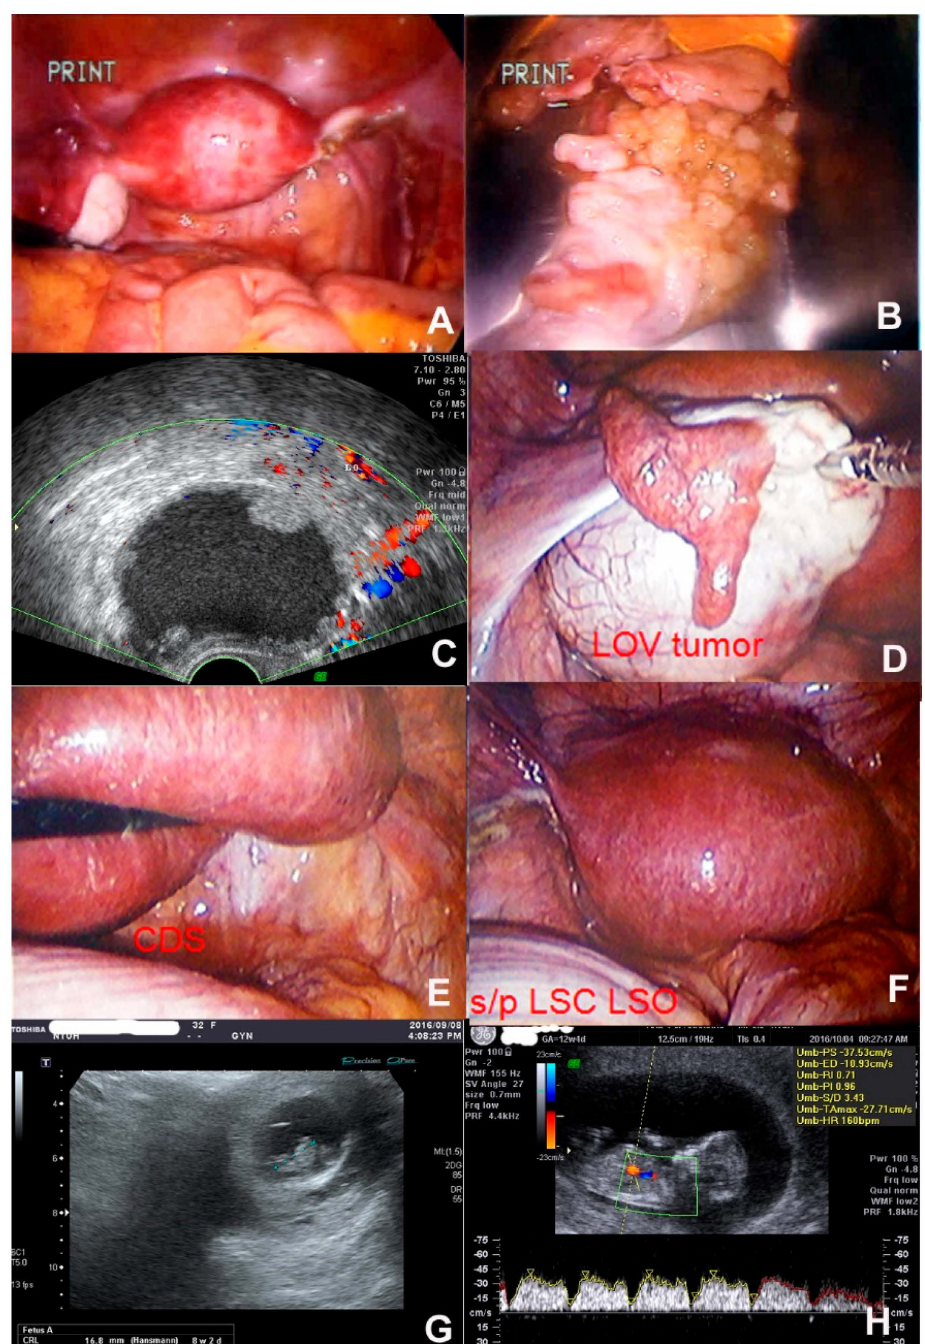
Figure 2. Seromucinous borderline tumor. ( A ) A 22-year-old woman who underwent laparoscopic right salpingo-oophorectomy for serous borderline tumor sized 7 cm; a normal left ovary. ( B ) Resected right ovary revealing a papillary solid growth inside. ( C ) Prenatal ultrasonography at GA 5 weeks revealing a 6 cm left ovarian cyst with sand-like content and multiple papillary components. ( D ) Laparoscopy reveal- ing a left ovarian tumor without tumor outgrowth. ( E ) Soft gravid uterus that should be touched gently. No adhesion noted after the previous right salpingo-oophorectomy performed 10 years ago. ( F ) Wound and gravid uterus at GA 8 weeks after laparoscopic left salpingo-oophorectomy. ( G ) Ultrasonographic confirmation of an intrauterine gestational sac with fetal heartbeat at GA 8 weeks. ( H ) Ultrasonogra- phy revealing normal fetal growth at GA 12 weeks when the placenta took function. LOV—left ovary, LSC—laparoscopy, LSO—left salpingo-oophorectomy, CDS—cul de